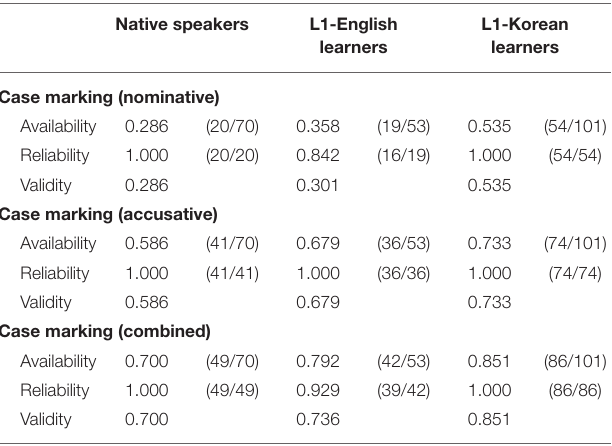
TABLE 8 | Availability, reliability, and validity of case-marking cues in sentences with an overt subject and object. Native